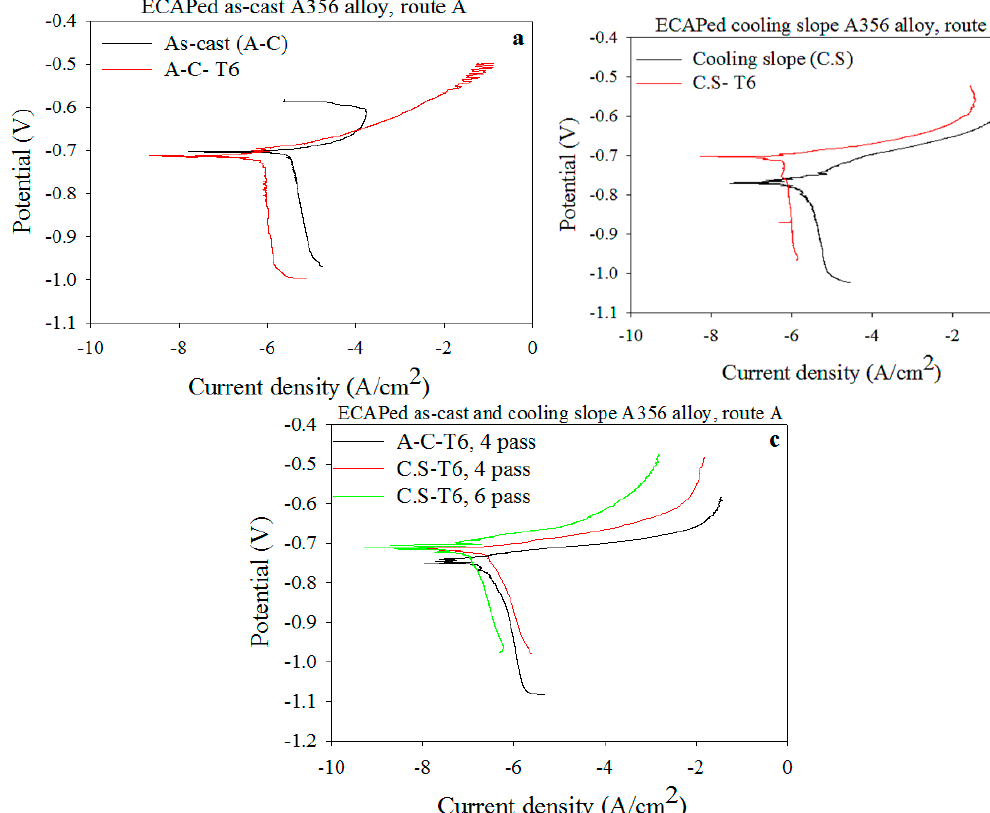
Figure 8. Polarization curves of A356 alloy before and after ECAP in 3.5 wt.% NaCl. ( a ) as-cast before and after T6; ( b ) cooling slope before and after T6; ( c ) heat-treated T6, as-cast and cooling slope after 4 and 6 passes.